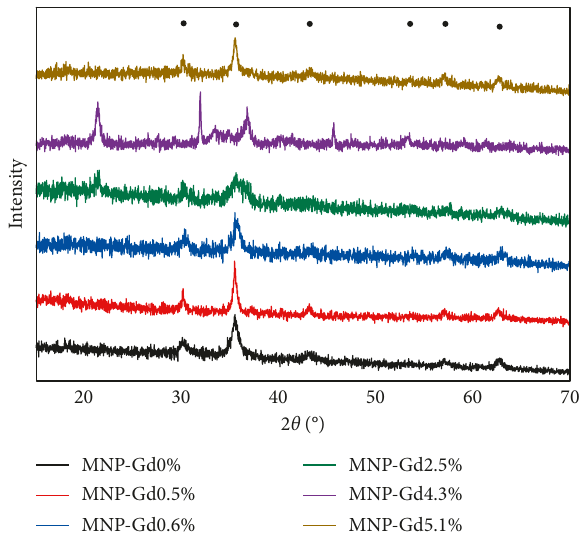
3+ ions in the samples, a cubic ini ) and actual content ( χ act , by XRF data) of Gd